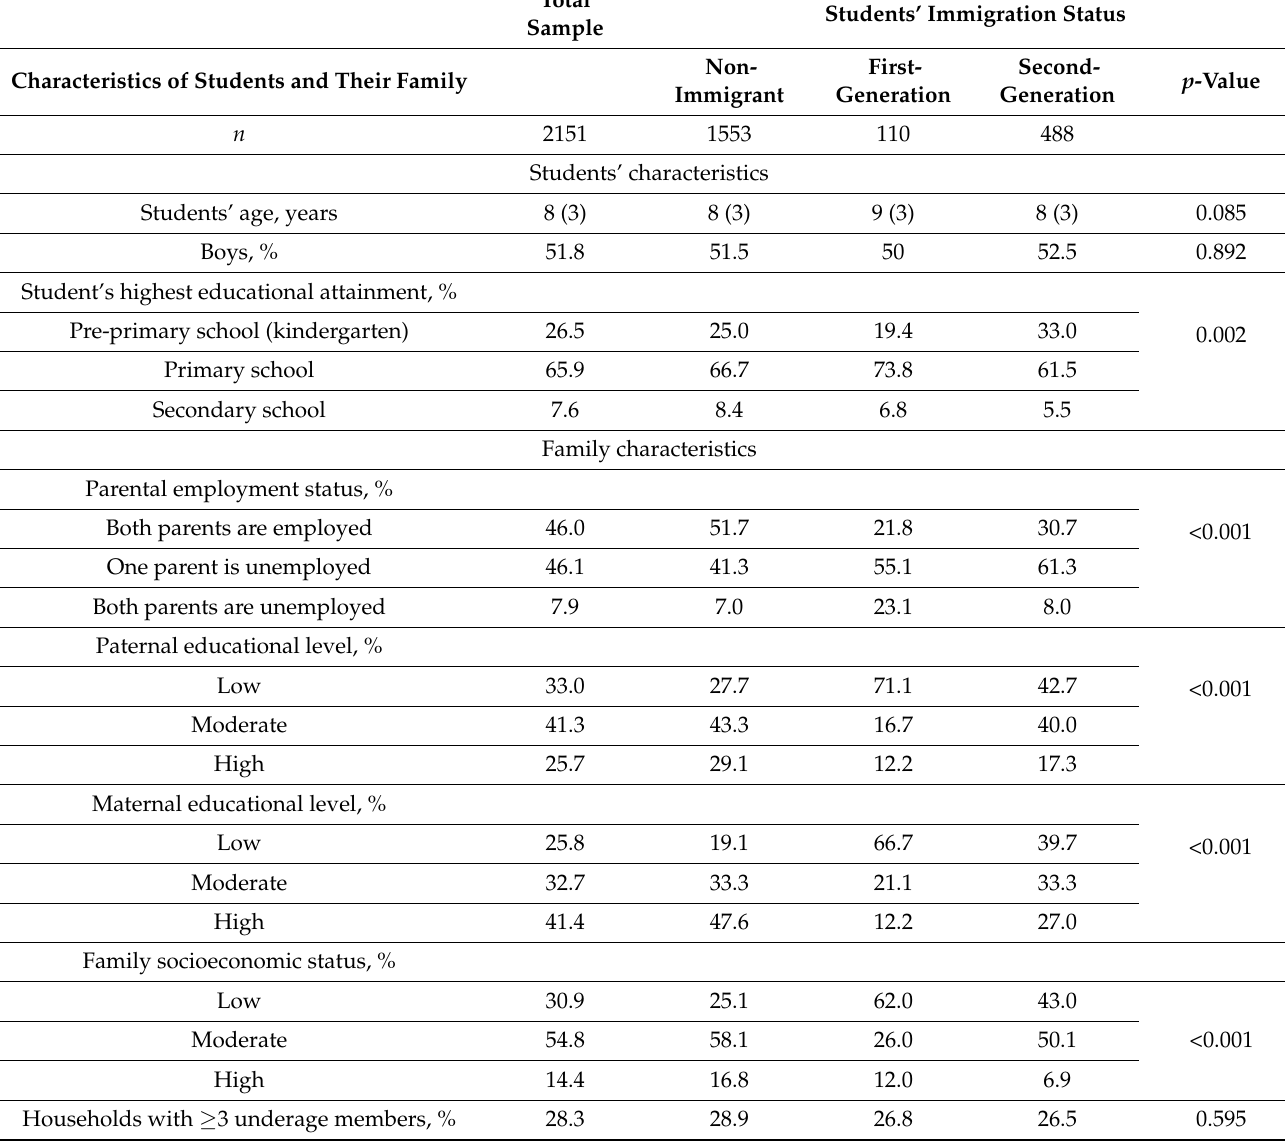
Table 1. Sociodemographic characteristics of students and their families who participated in the DIATROFI Program, in the total sample and according to students’ immigration status. Total